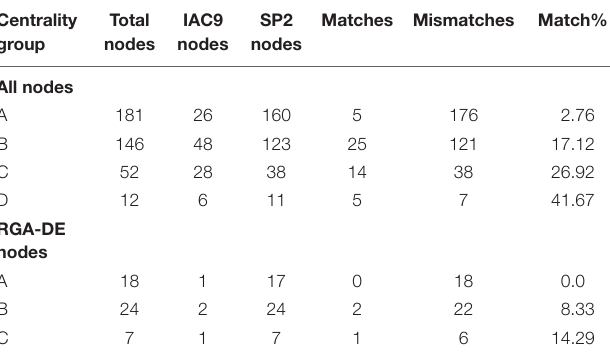
TABLE 3 | Comparison by K -means degree centrality groups between the core-periphery sub-networks of IAC9 and SP2 generated through the depth-first search (DFS) of the RGA-DE nodes from transcriptome experiments with IAC and